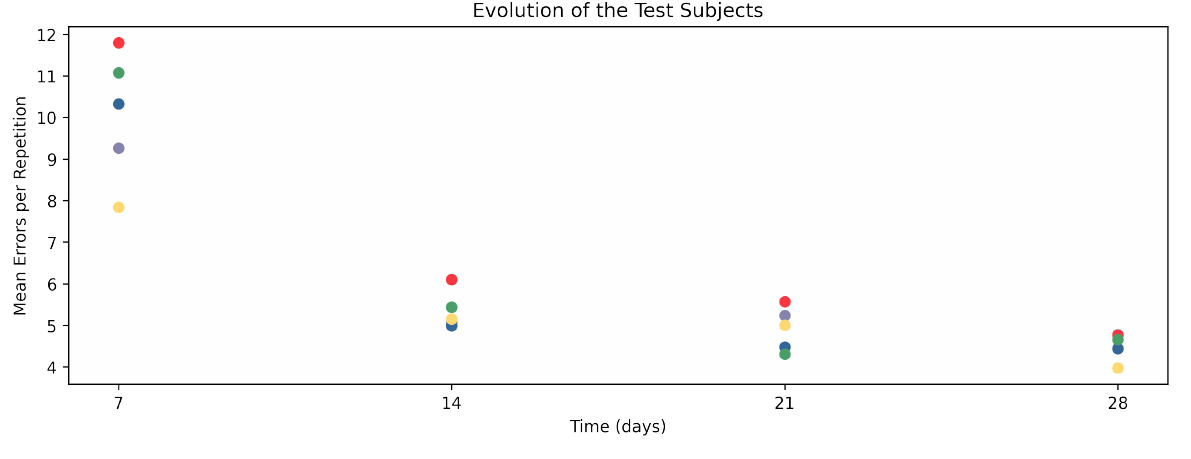
Figure 12. Evolution of users’ errors.